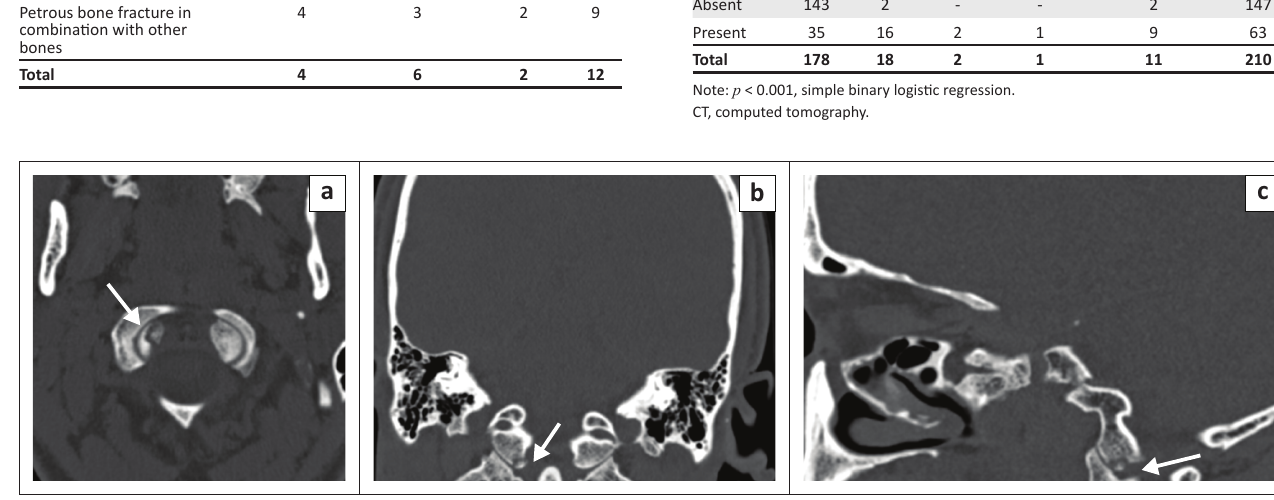
TABLE 3: Summary of petrous bone fractures on computed tomography Nature of petrous bone involvement Isolated petrous bone fracture Petrous bone fracture in combination with other